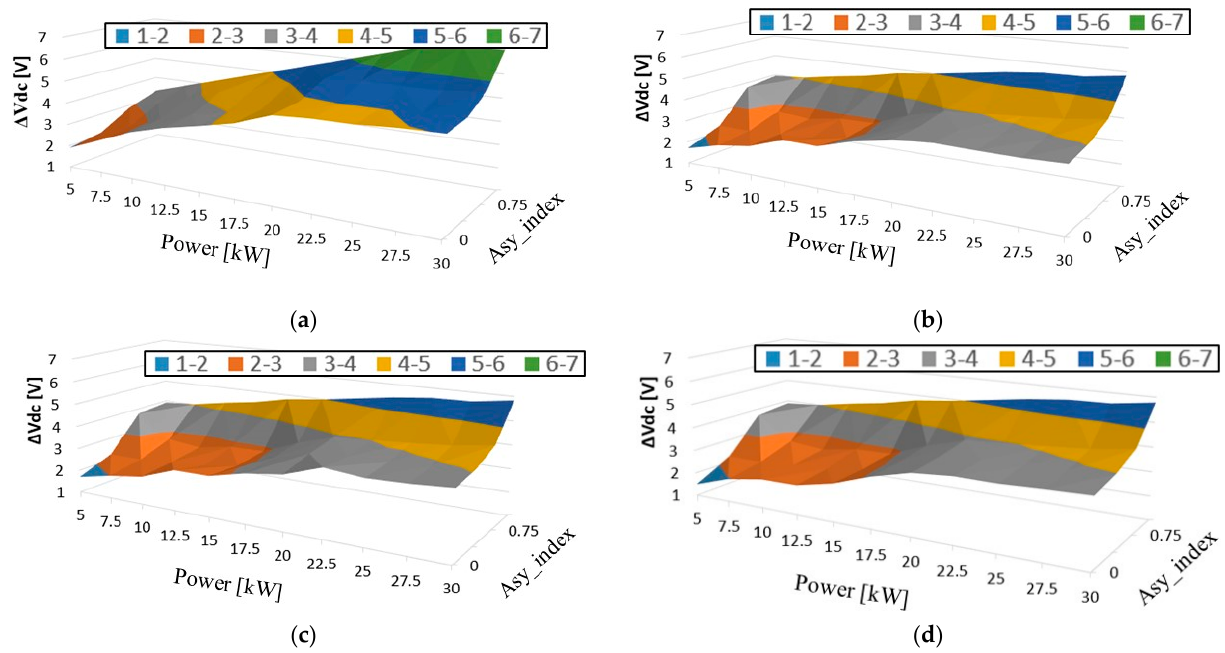
Figure 12. Comparison of voltage volatility performance of a four-leg inverter under unbalanced load condition: ( a ) two-level three-leg four-wire type, ( b ) two-level four-leg type, ( c ) three-level three-leg four-wire type, and ( d ) three-level type four-leg inverter.